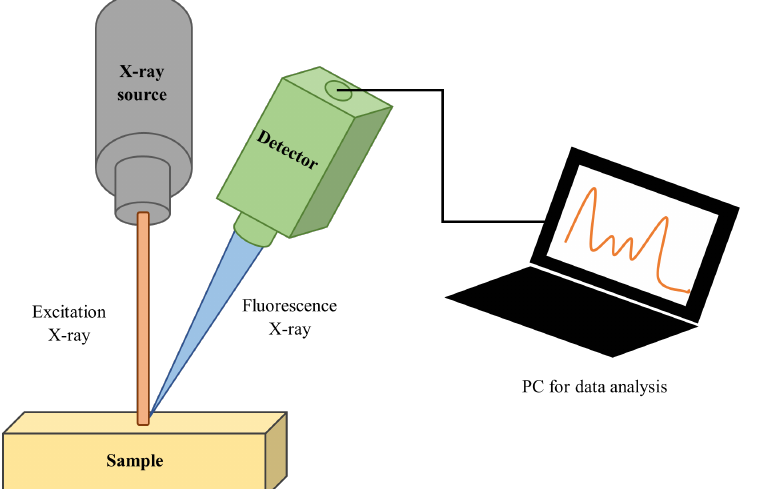
Figure 3. Schematic representation of a typical XRF